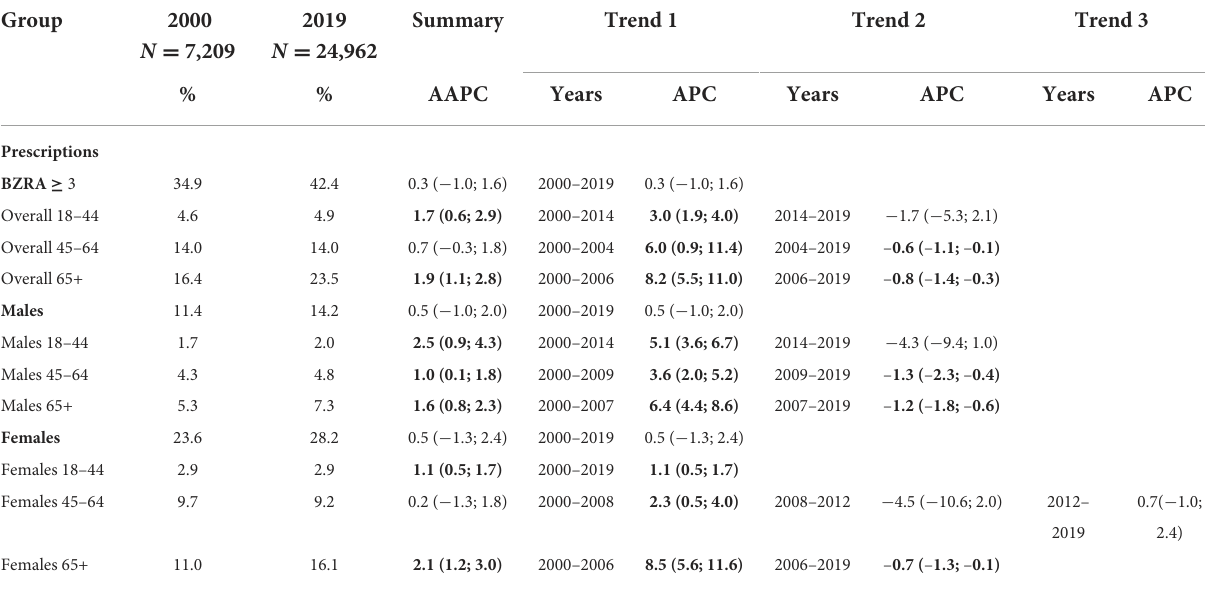
TABLE 4 Trends in age- and sex-standardized BZRA prescription rates among patients who received ≥ 3 BZRA prescriptions in 1 year between 2000 and 2019.